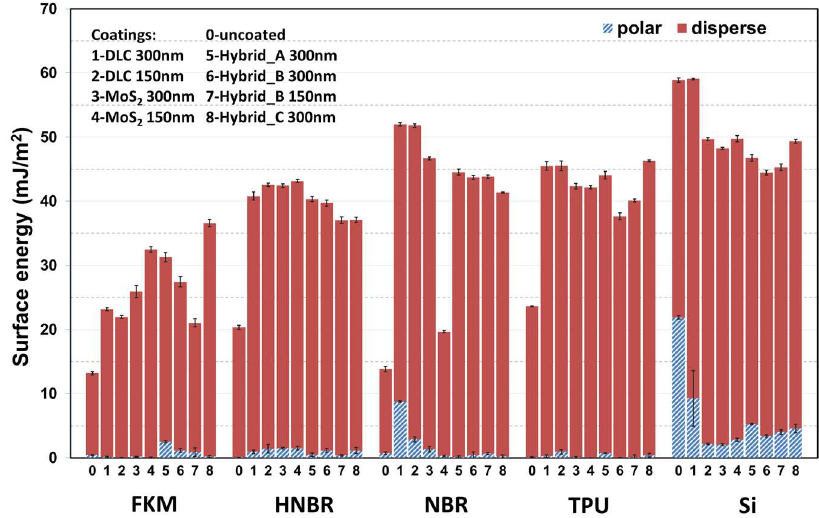
Figure 5. Surface energy of uncoated and coated substrates.